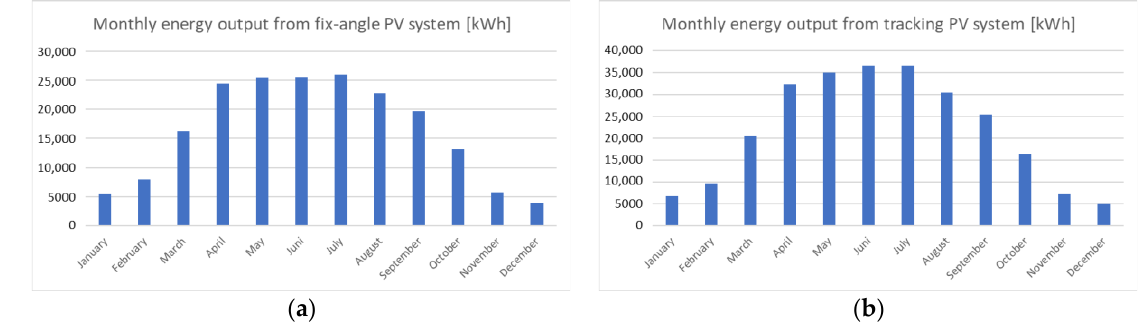
Figure 4. Expected average amount of energy from solar panels at the installation location: ( a ) an optimal constant panel orientation; ( b ) two-axis tracking. Table 1. Expected average amount of energy from solar panels at the installation location [kWh].